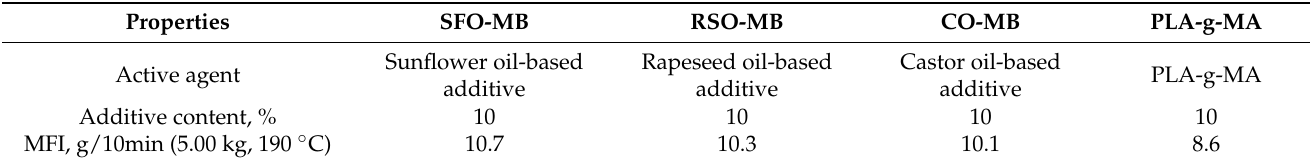
Table 2. The main properties of masterbatches (MB).